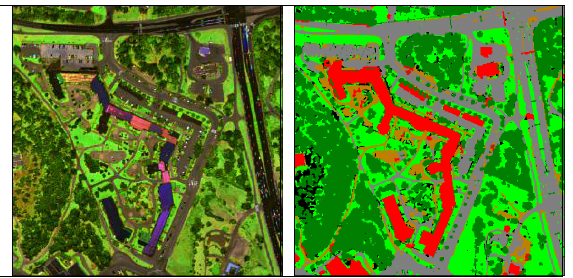
Figure 4. Optech Titan colour coded image (left) and classified image